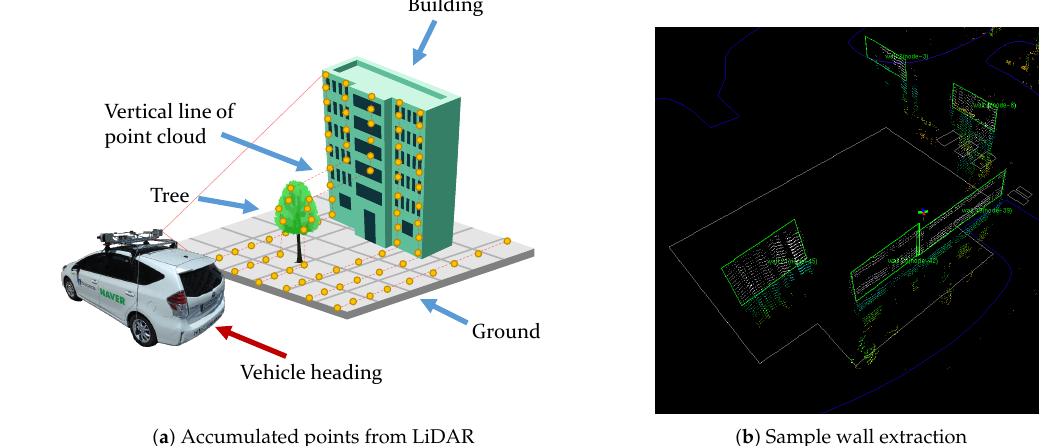
Figure 5. ( a ) Illustration of point cloud accumulation from vertically installed side scanning LiDAR. We only collect a single scan line per vehicle pose, and accumulate lines into a local point cloud set via motion. ( b ) An example of wall represented by digital map and point cloud map (white points in green box). For wall segmentation, we use 5-point Random Sample Consensus (RANSAC)-based plane